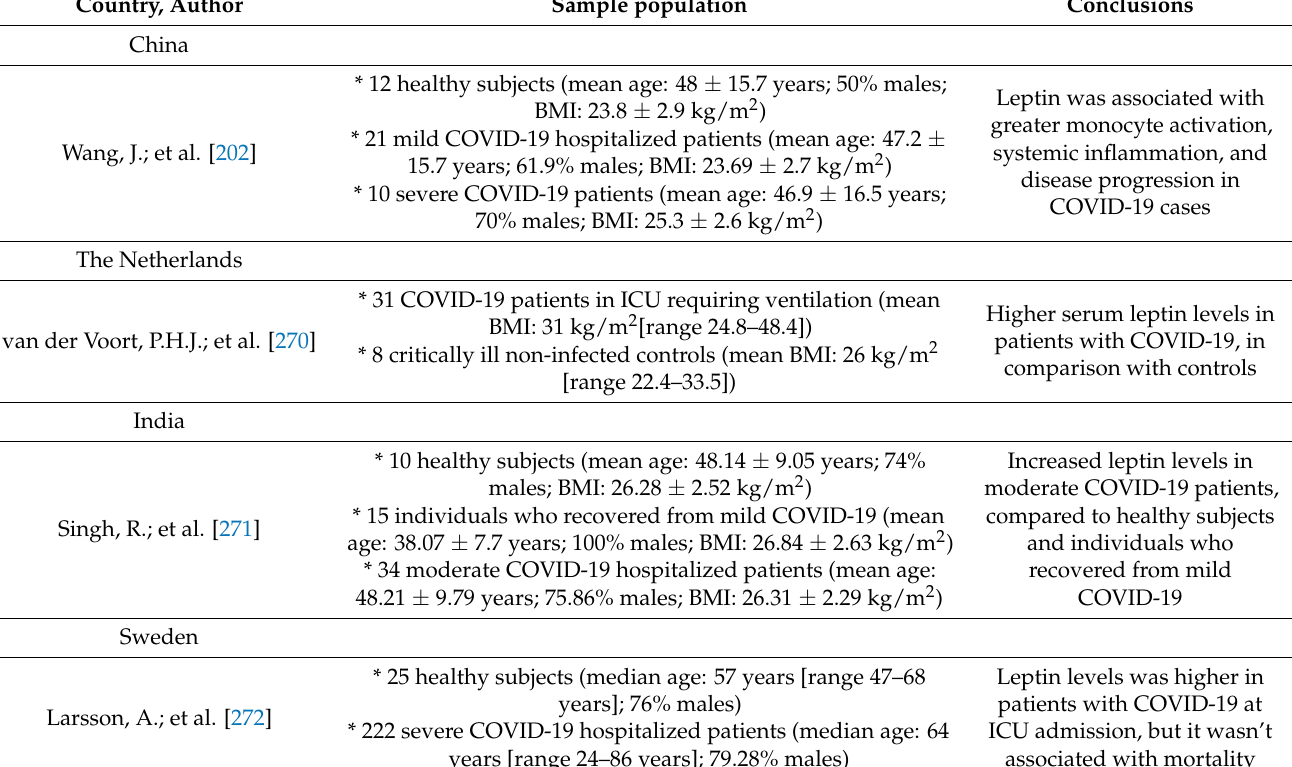
Table 1. Human studies finding higher leptin levels in COVID-19